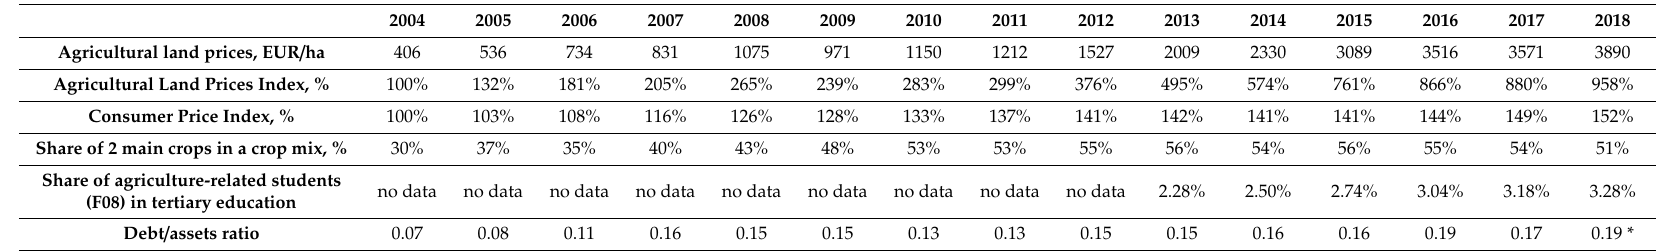
Table 1. The quantitative expression of some researched